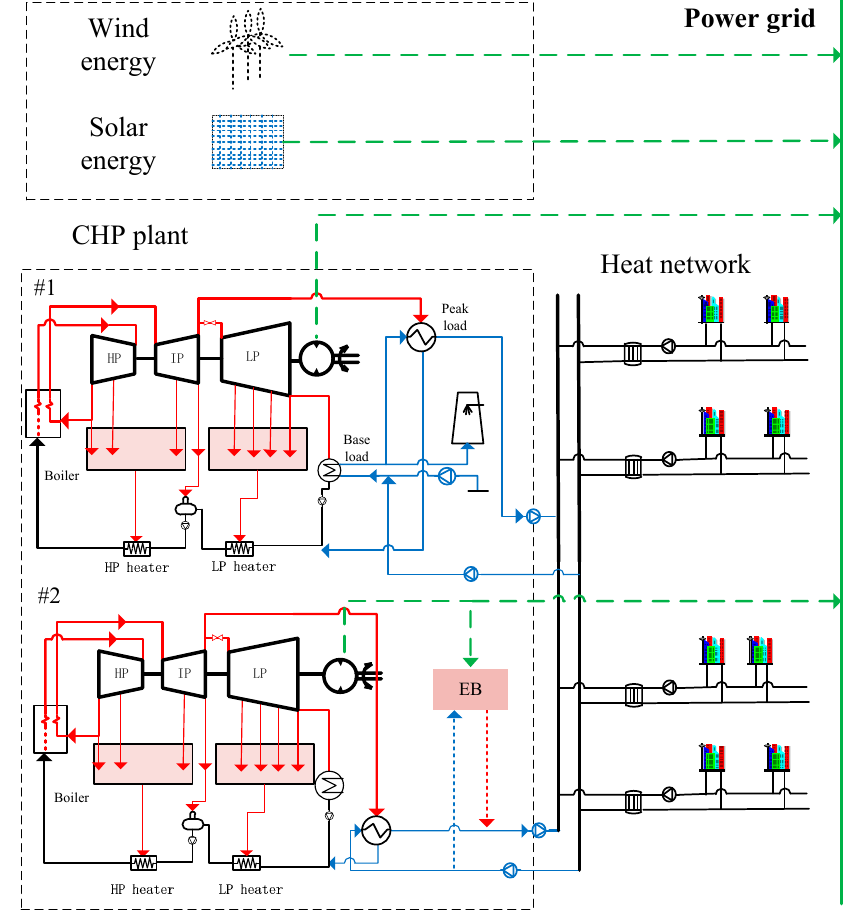
Figure 1. CHP energy supply system diagram. Unit 2# has undergone the transformation of the cutting-off low-pressure cylinder. In the heating season, the mode of extraction heating and cylinder cutting can be switched according to the demand. During the heating period, the low-pressure cylinder is cut off by controlling the butterfly valve switch on the connecting pipe of the low-pressure cylinder to “cut” and “connect” the low-pressure cylinder so that this part of the steam can enter the heating network for external heating.